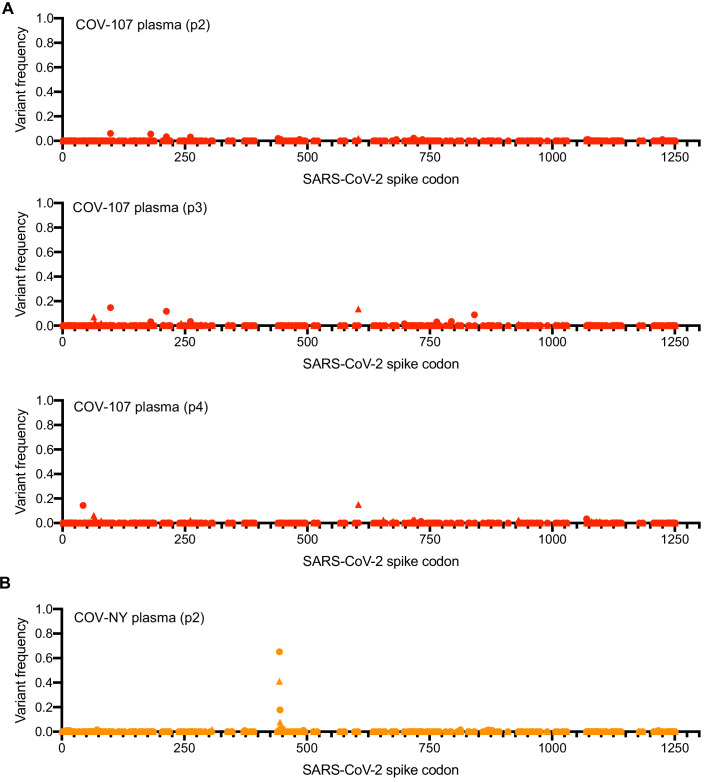
Analysis of S-encoding sequences following rVSV/SARS-CoV-2/GFP replication in the presence of convalescent plasma COV-107 and COV-NY.(A–B) Graphs depict the S codon position (X-axis) and the frequency of non-synonymous substitutions (Y-axis) following the second, third or fourth passage (p2–p4) of rVSV/SARS-CoV-2/GFP on 293T/ACE2(B) cells in the presence of COV-107 plasma (A), or second passage in the presence of COV-NY plasma (B). Results are shown for both rVSV/SARS-CoV-2/GFP variants (the frequency of 1D7 mutations is plotted as circles and 2E1 mutations as triangles).